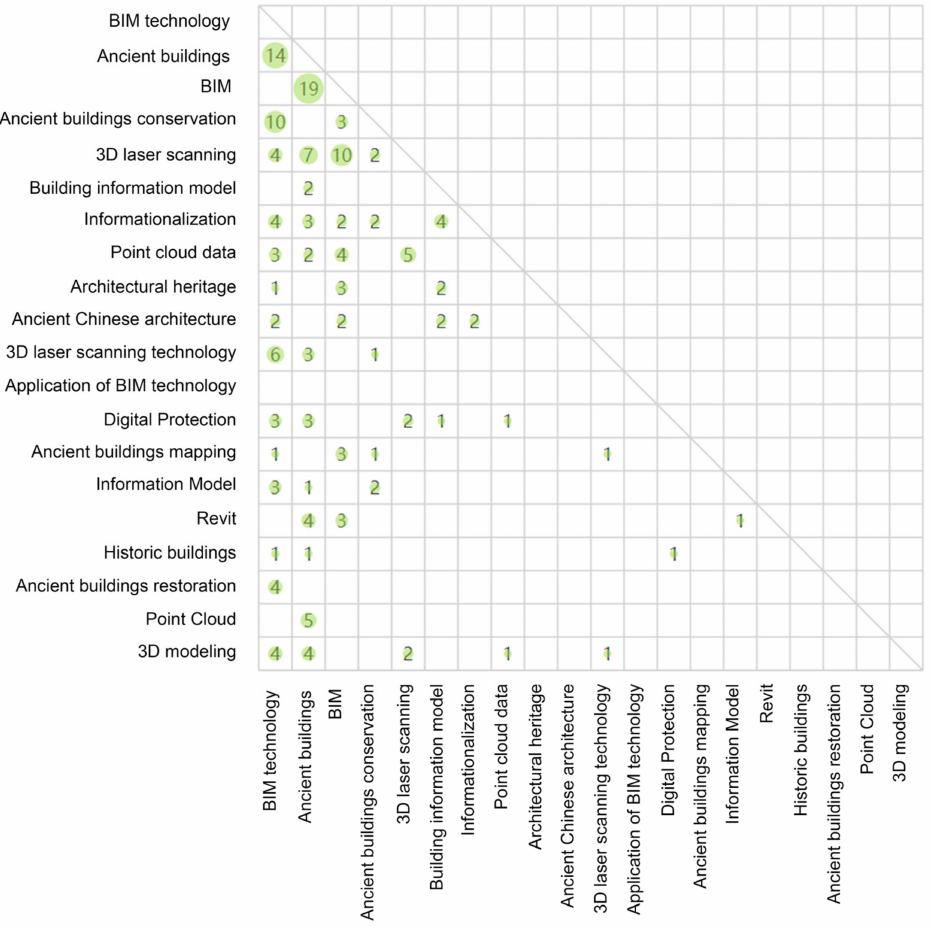
Figure 4. Cross-thematic analysis of “BIM” and “ancient architecture”. The time series analysis of the year of journal publication of the 167 articles through SATI platform analysis is shown in Figure 6, and it is found that the first journal “ Urbanism and Architecture ” and the second journals “ House ” and “ Science and Technology Innovation ”, which are tied for the first number of studies published, both entered “BIM” and “archi- tectural heritage”. The top ten journals are basically from the top of the list. The top ten journals basically started in 2013, and their annual publication volume was not high, but showed a gradually increasing trend after 2018. Other journals have not shown significant fluctuations in the thematic literature distribution, which suggests that there is a lack of journals that focus on this field